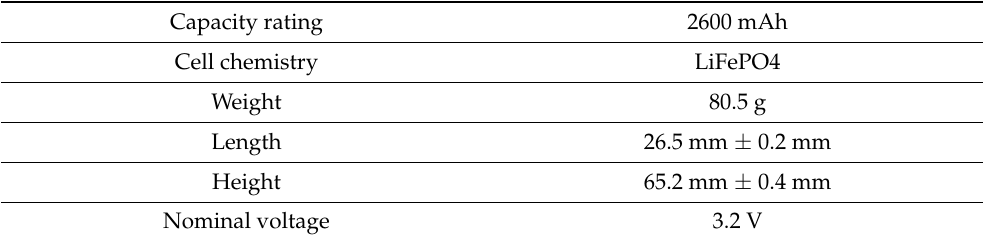
Table 1. Characteristics of the LFP